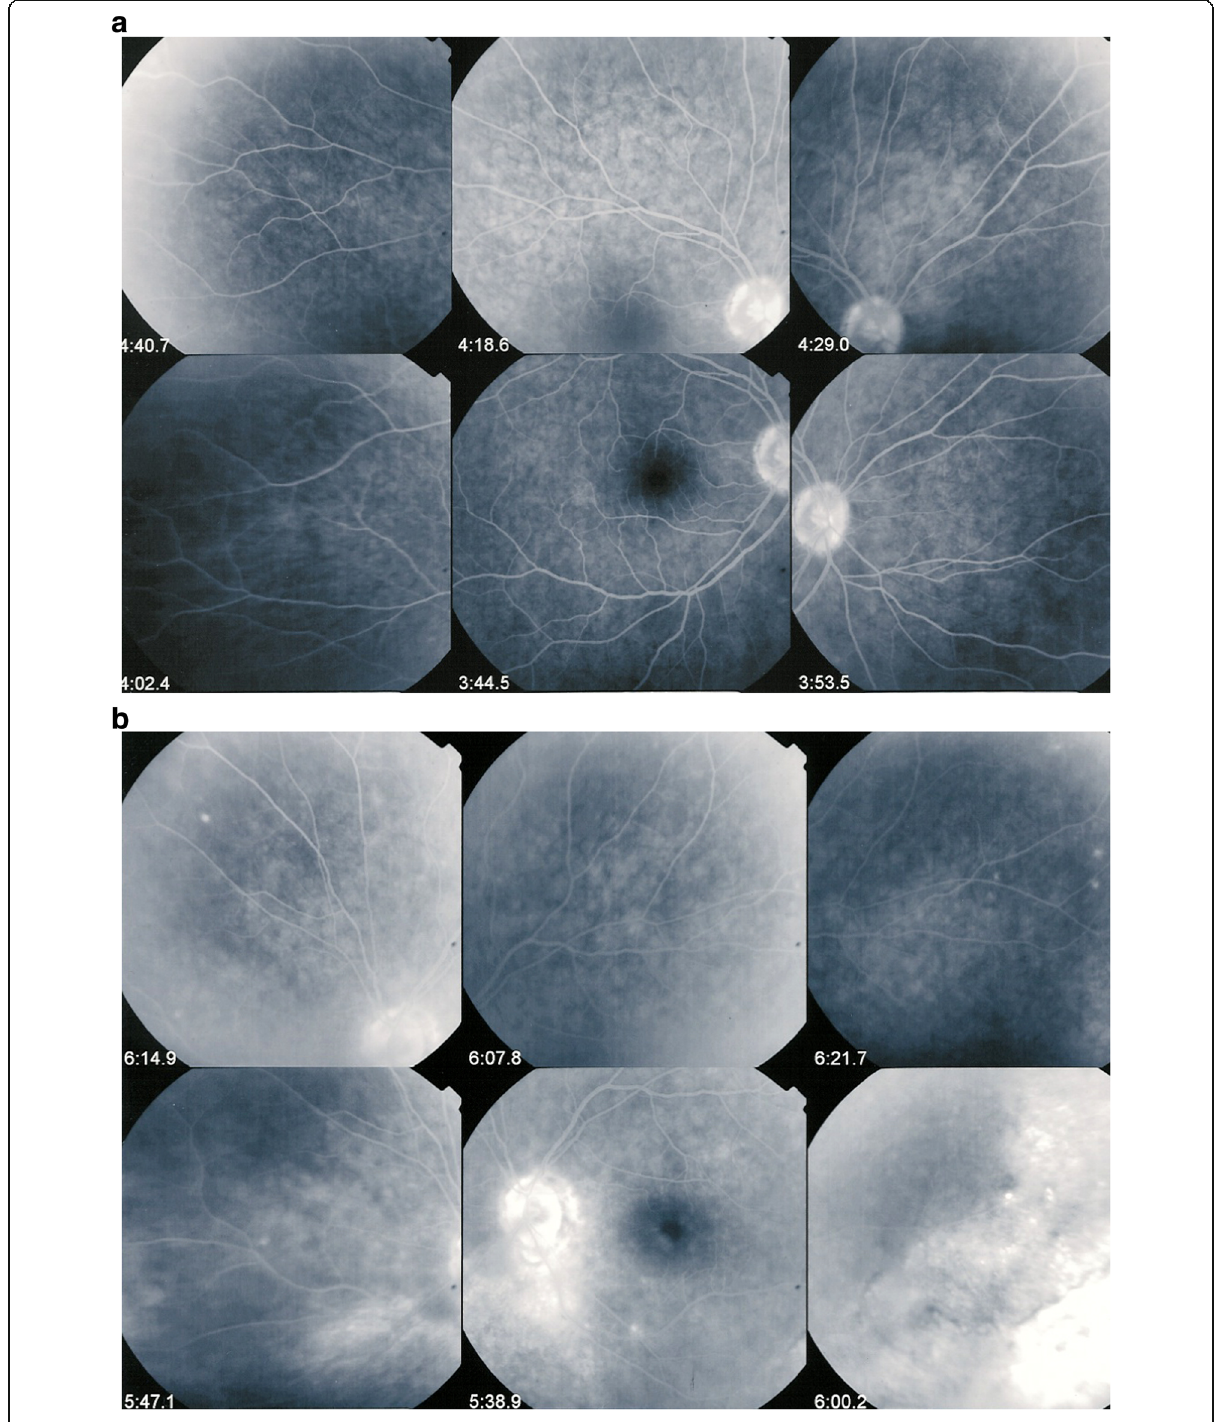
Fig. 2 a FA OD of VKH case at presentation. FA is within normal limits. b FA OS of VKH case at presentation. FA shows disc hyperfluorescent and hyperfluorescent areas